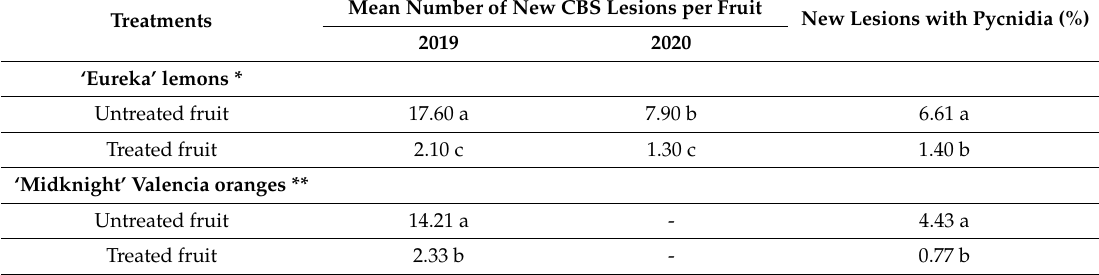
Table 1. Mean number of new CBS lesions and percentage of pycnidia-forming lesions per fruit on ‘Eureka’ lemons and ‘Midknight’ Valencia oranges after exposure to standard postharvest treatments consisting of pre-packhouse drench, chlorine wash, fungicide dips, and wax application, as well as a 5-week period of cold storage at 4 ◦ C (oranges) and 7 ◦ C (lemons) and 2 weeks at 25–27 ◦ C under constant light and > 80% humidity.